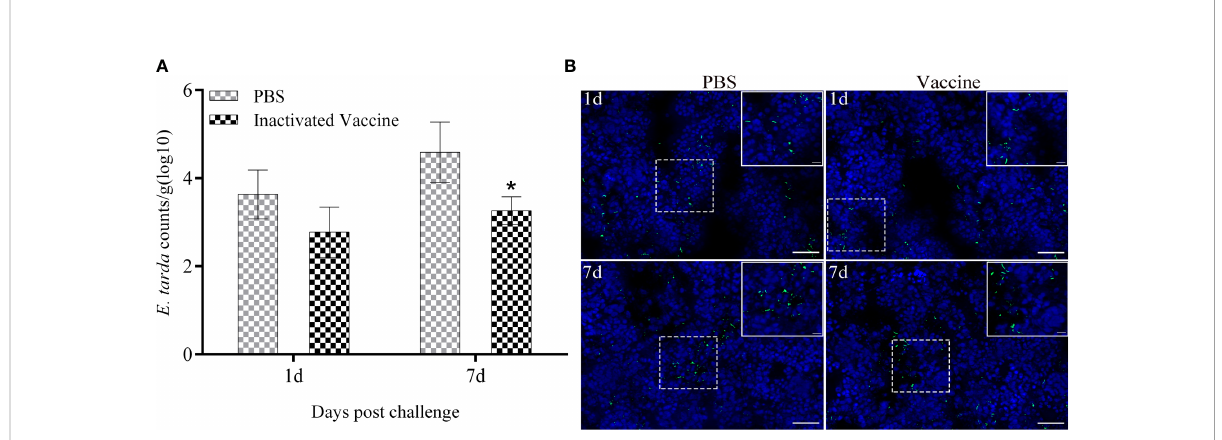
FIGURE 2 Bacterial load in the spleen of fl ounder sampled from the PBS and inactivated vaccine groups was determined by qRT-PCR at 1 st and 7 th post challenge day (A) . Values are shown as mean ± SD (N = 3). Asterisks on the bars represent statistical signi fi cance (* p < 0.05). Distribution of E tarda in the spleen (B) observed by indirect immuno fl uorescence (Bar = 20 um). The corresponding enlargement of the diagram in the dotted box is shown in the upper right of the image (Bar = 5 um). The green fl uorescent represents signal of E tarda . Cell nuclei were stained with DAPI in